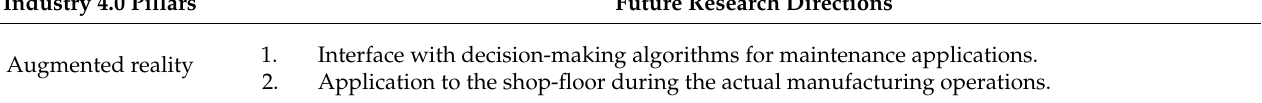
Table 11. Research agenda of decision-making for Industry 4.0 maintenance applications.